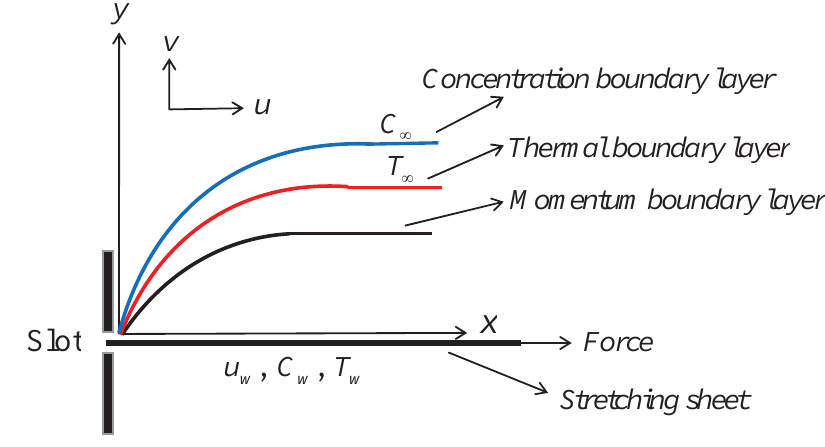
Figure 1. Physical